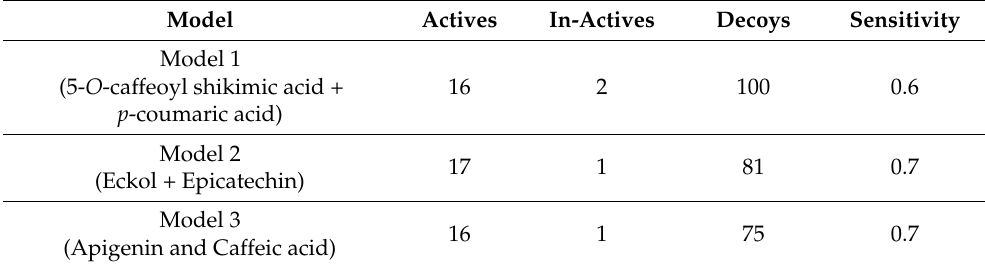
Table 1. Validation hit rate of the generated pharmacophore